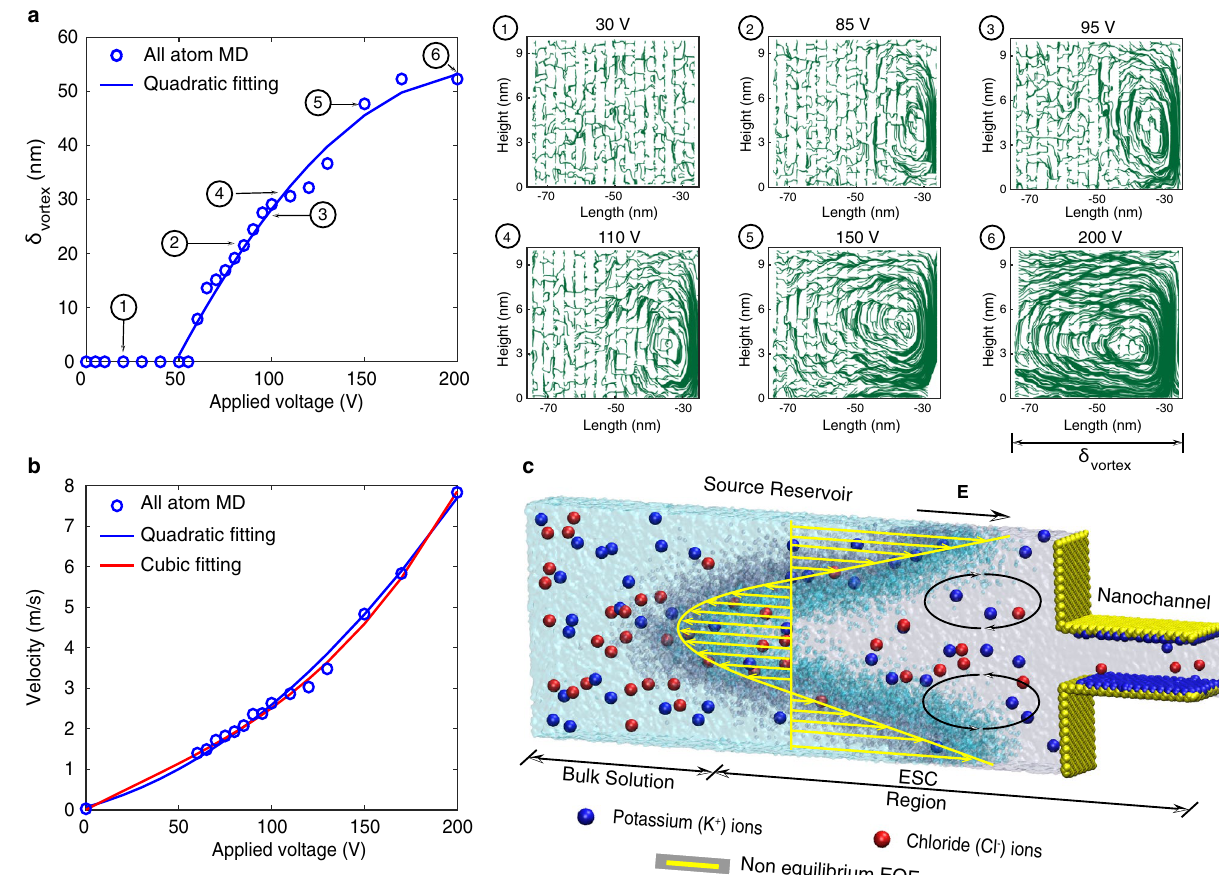
Figure 3. ( a ) indicates the variation of the size of the counter-rotating vortices ( δ vortex ) with the applied voltage. Further, it shows the fluid flow streamlines for the six different voltages. The counter-rotating vortices are almost symmetry about the centre of the source reservoir. For clear visualization, we show one-half of the vortices. ( b ) shows the variation of the velocity of the water inside the source reservoir with the applied voltage. It follows the quadratic scaling with the applied voltage similar to the earlier theoretical and experimental results. ( c ) illustrates the snapshot of the counter-rotating vortices from all-atom MD simulation, corresponding to the overlimiting resistance region. Drawing in ( c ) was created using VMD software (www. ks. uiuc. edu/ Devel opment/ Downl oad/ downl oad. cgi? Packa geName= VMD and version